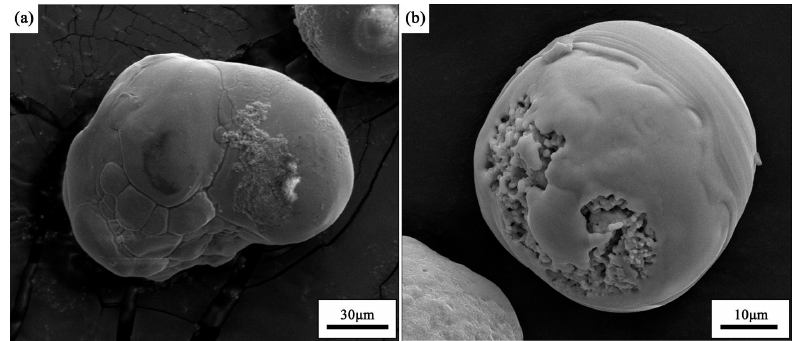
Figure 4. Surface and cross-sectional SEM micrographs of the collected YSZ particles (referred as C- AS) particles: ( a ) overall surface morphology; ( b ) surface morphology under high magnification; ( c ) overall cross-sectional morphology; and ( d ) cross-sectional morphology under high magnification.